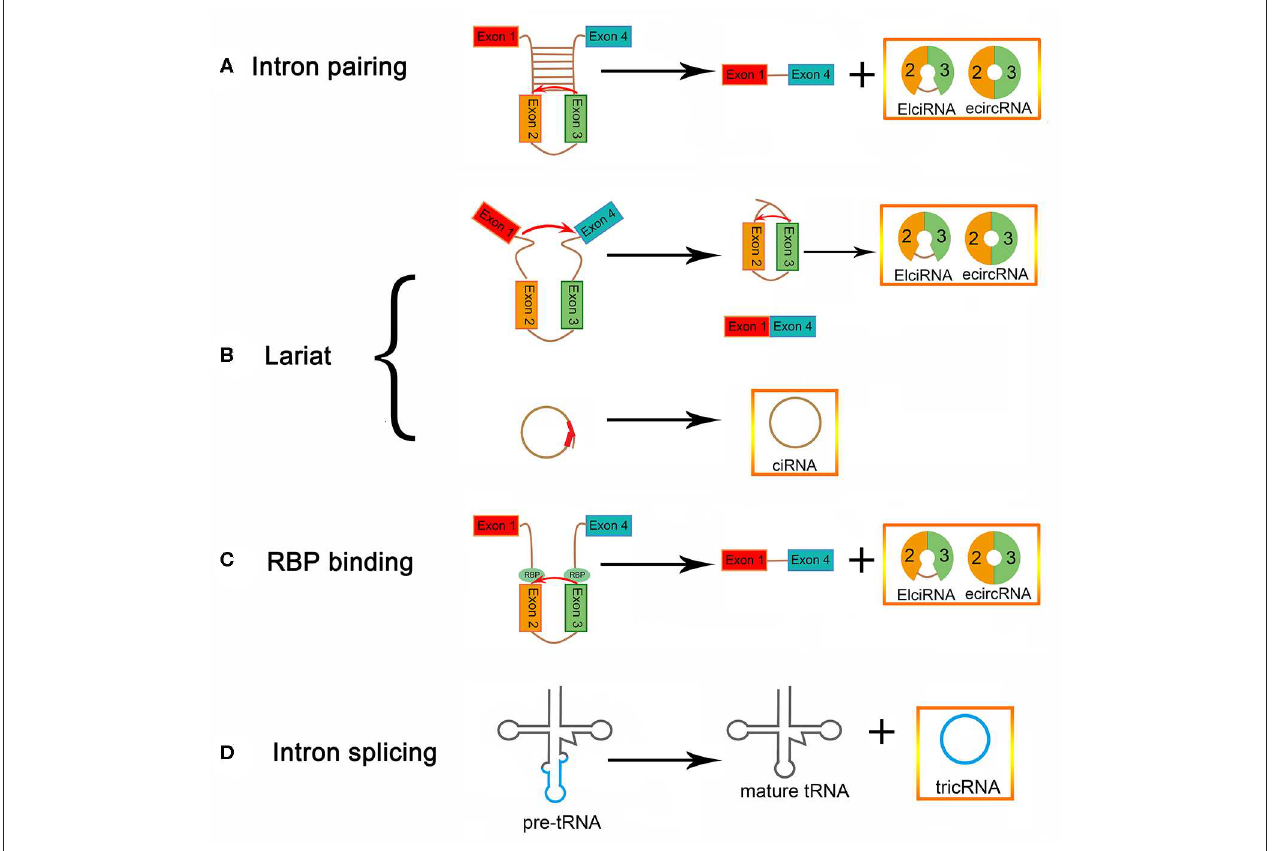
FIGURE 1 | circRNA biogenesis (A) EIciRNA biogenesis and ecircRNA biogenesis via intron pairing-driven circularization. (B) EIciRNA, ecircRNA, and ciRNA biogenesis via lariat-driven circularization. (C) EIciRNA biogenesis via RBP-associated pairing-driven circularization. (D) TricRNA biogenesis via intron splicing from